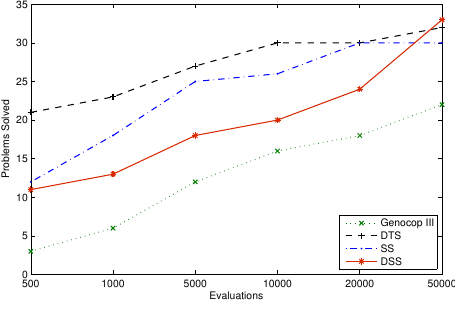
Figure 9. Number of solved